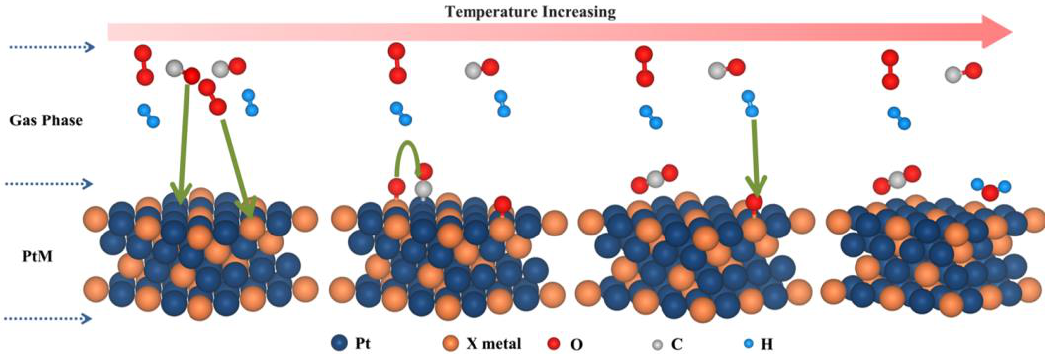
Figure 2. Schematic illustration of CO preferential oxidation (PROX) pathways on Pt-M alloy catalyst. Reprinted with permission from [45], American Chemical Society, 2018.